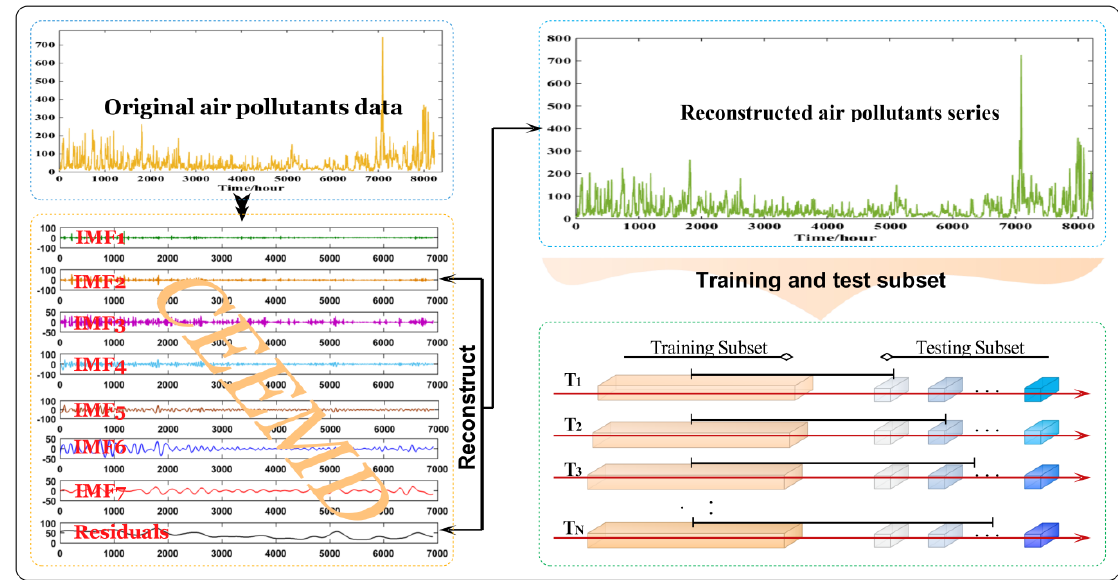
Figure 1. Data preprocessing for EWS.